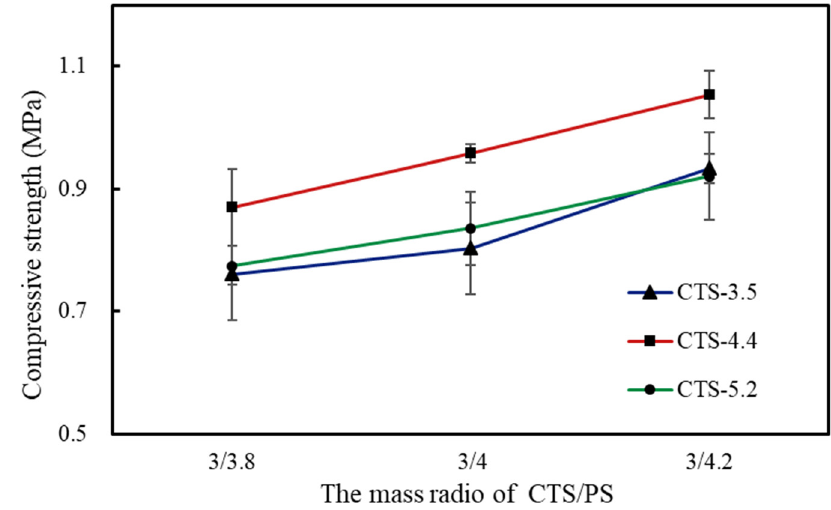
Figure 5. Compressive strength of foams with chitosan solution for 4.2 wt%.